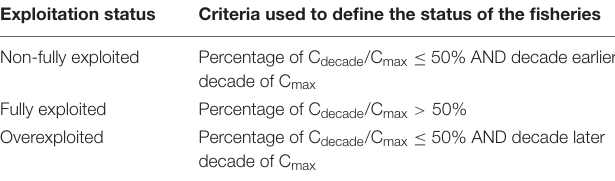
TABLE 2 | Criteria used to classify the exploitation status of the fisheries in three categories: non-fully exploited, fully exploited, and overexploited (adapted from Froese and Kesner-Reyes, 2002) (C decade , average landings by decade; C max , average landings of the decade with the highest value